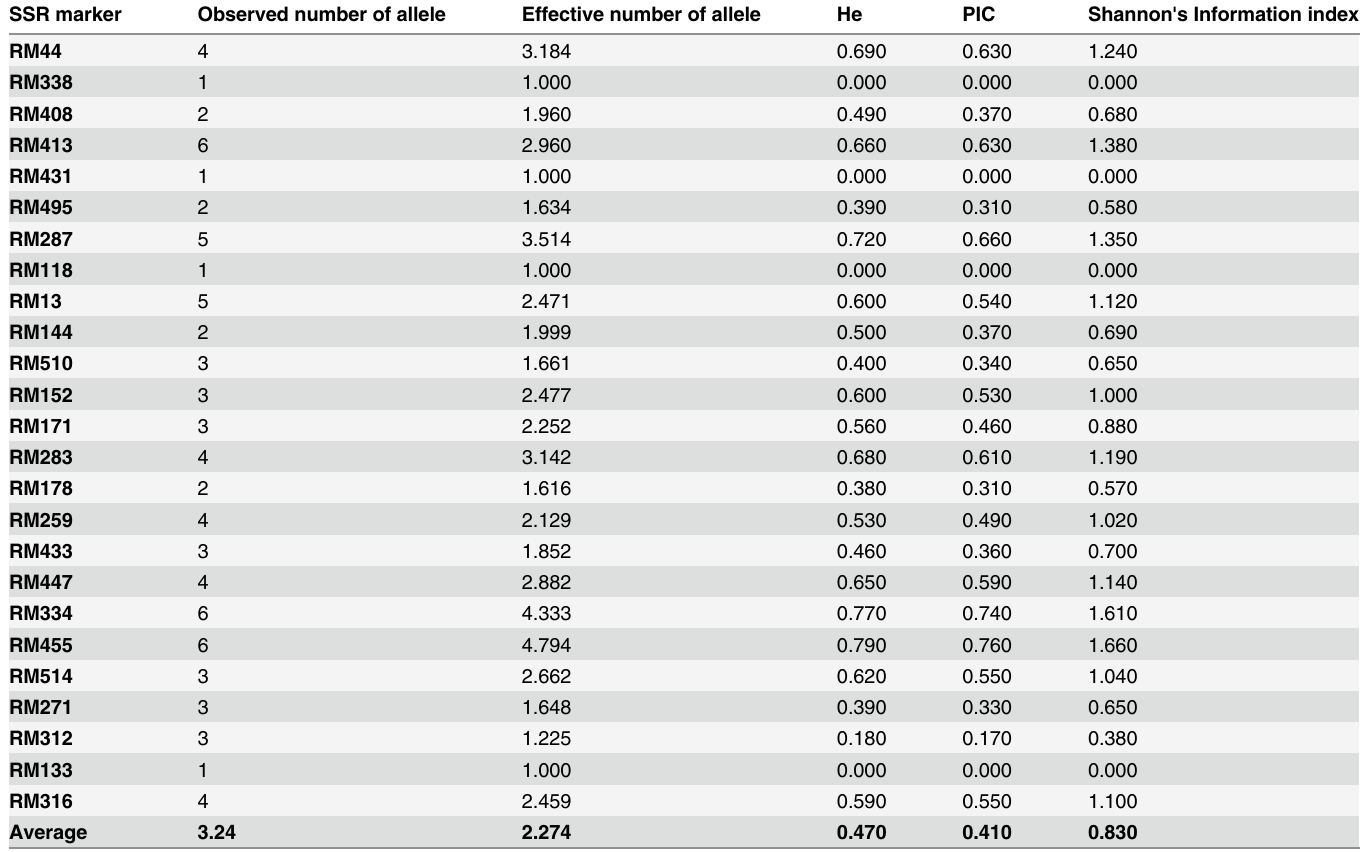
Table 3. Expected Heterozygosity (He), Polymorphic Information Content (PIC), and Shannon ’ s Information Index of 25 SSR